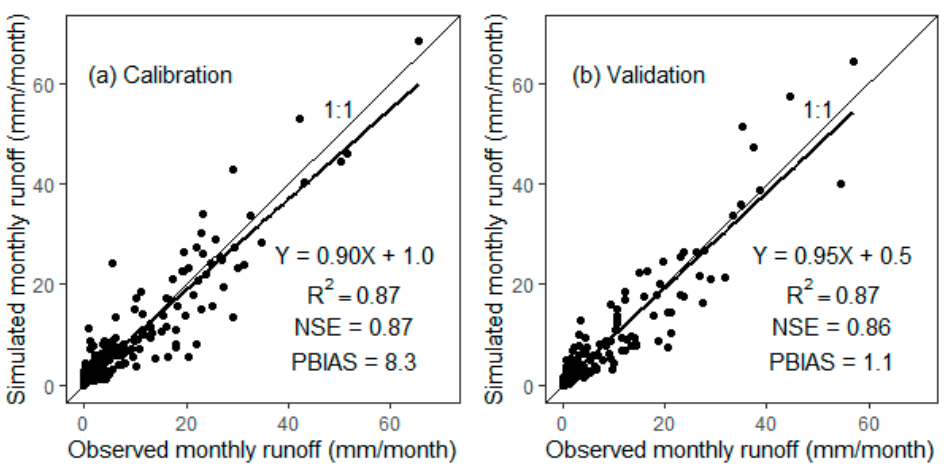
Figure 4. Correlation of monthly simulated and observed runoff in model calibration and validation in the Wooroloo Brook catchment, southwestern Australia.